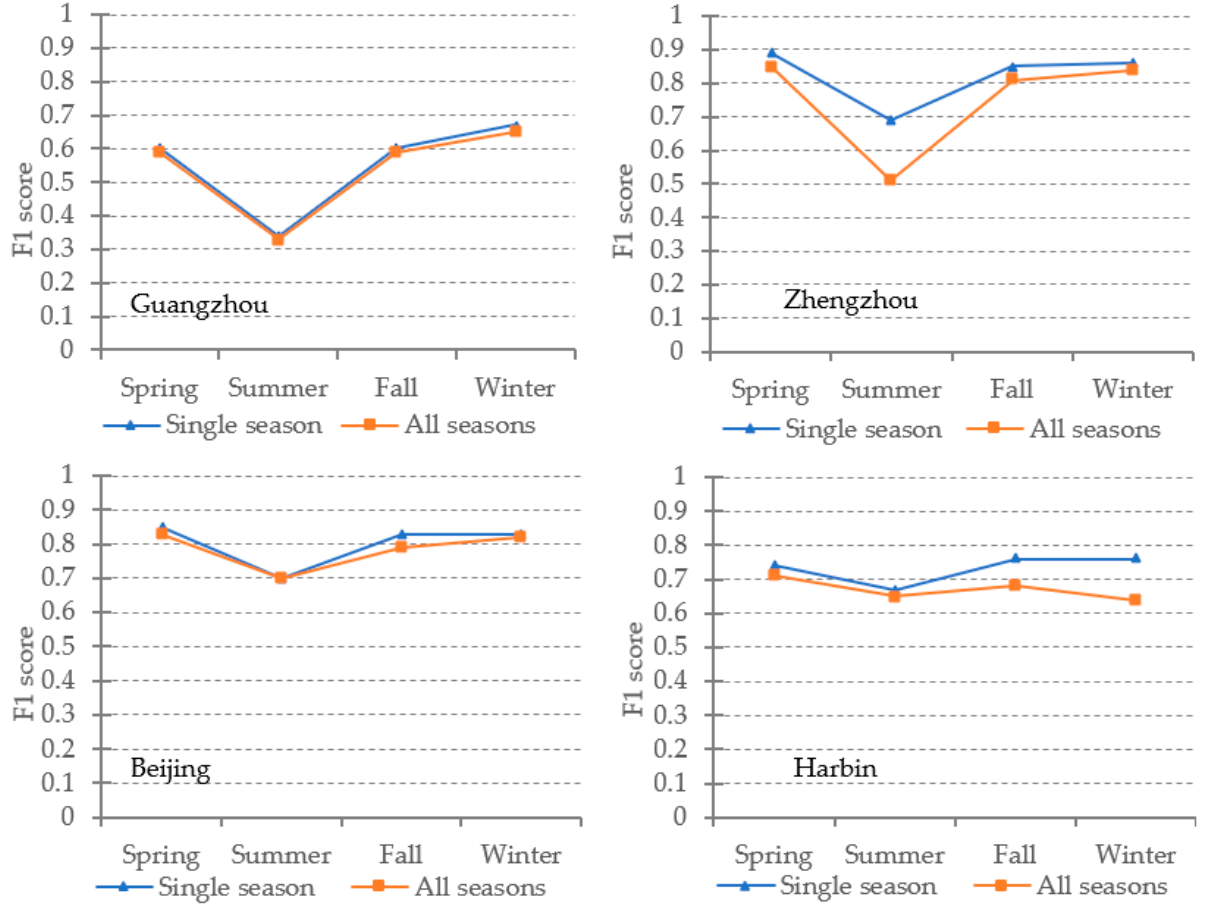
Figure 7. F1 scores of FCN models validated on different combinations of region and season. Single season model in blue line is trained on samples in a specific combination of season and region. All-season model in yellow line is trained on the seasonally combined samples in a specific region.